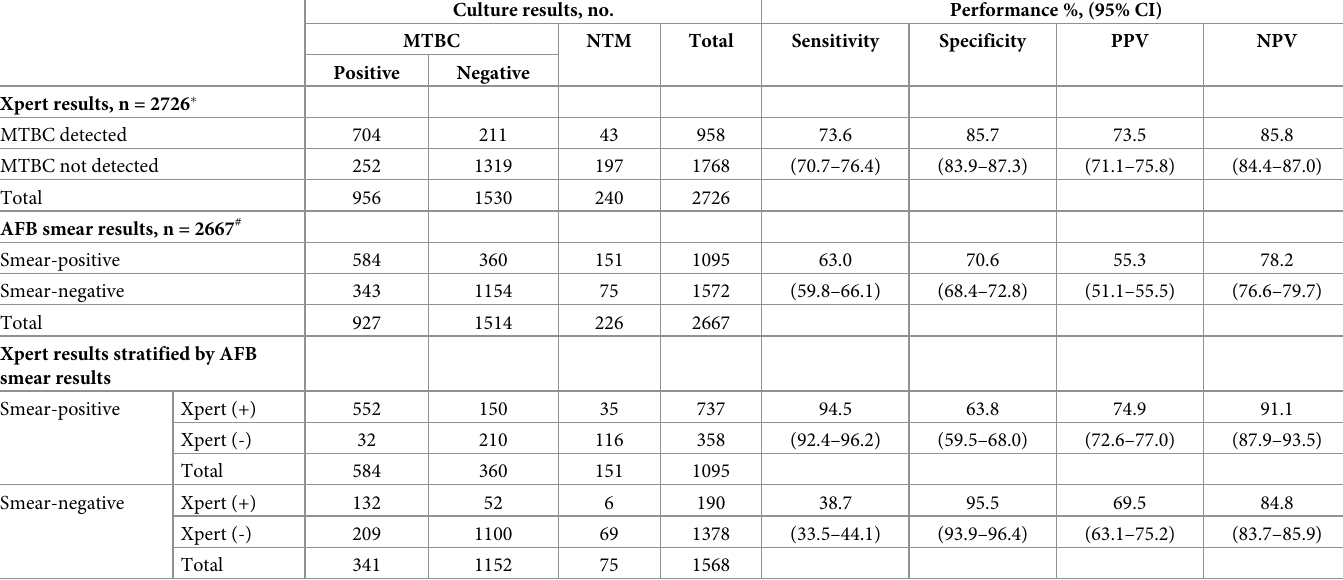
Table 2. Performance of the Xpert test for the detection of MTBC, compared to smear and culture results. Culture results,